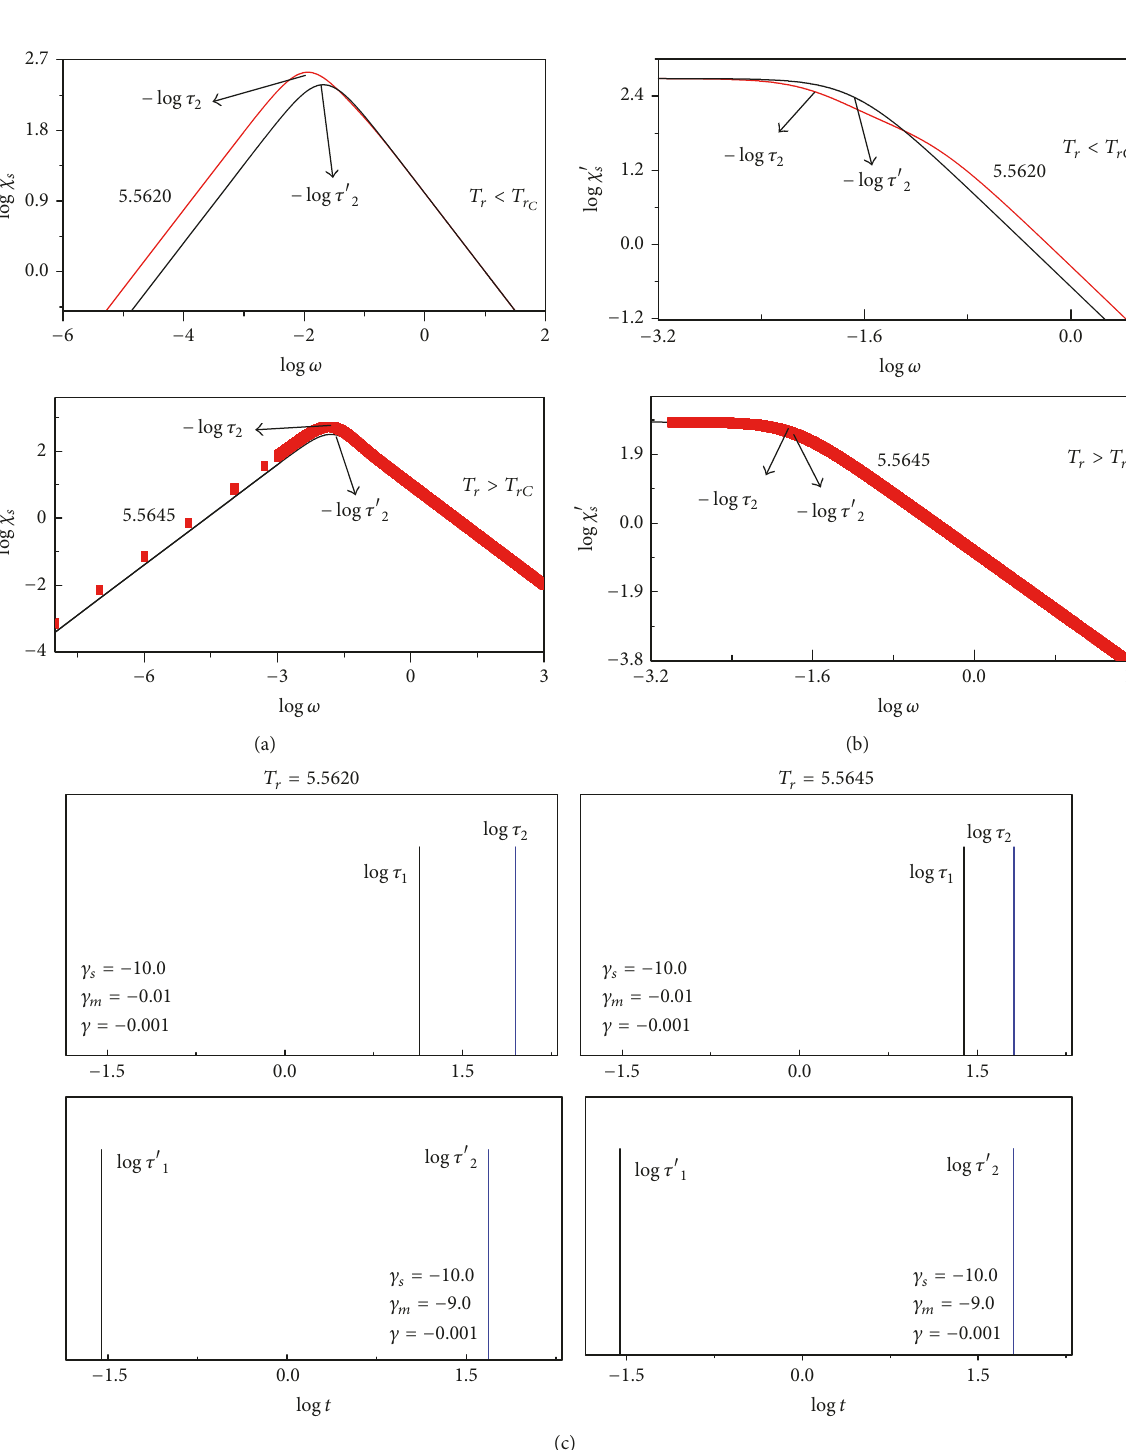
Ising model, an analysis of the real and imaginary parts of (𝜔) has been elucidated using Cole-Cole plot of 𝜒 𝜒 𝑠